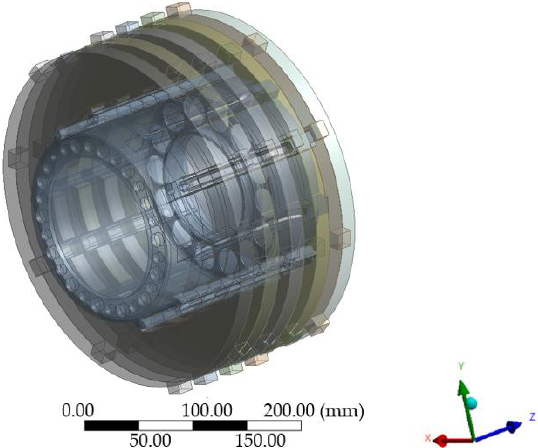
Figure 5. Three-dimensional model of a brake assembly of the Airbus A320 modeled in ANSYS software.